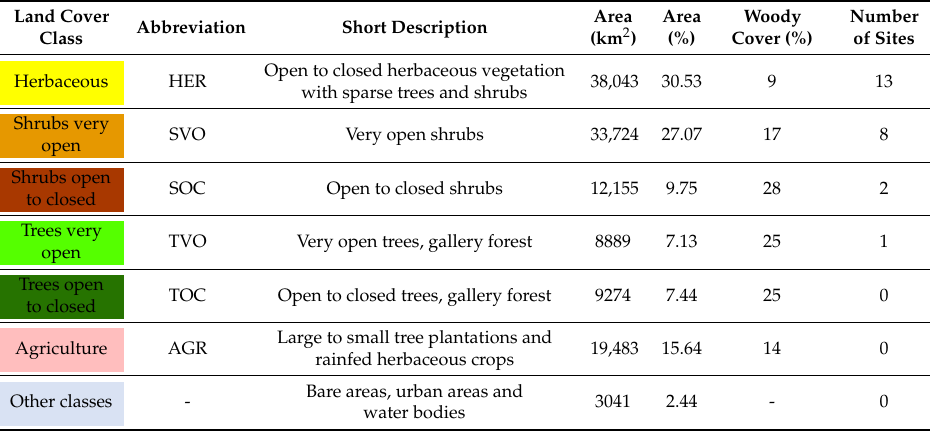
Figure 1. Location of the monitoring sites and the main land cover classes [51]. The sites are identified by their position in a grid where Cx indicates the column number and Ly corresponds to the line number with x and y varying between 1 and 9. The isohyets are based on average rainfall estimates provided by FEWS NET between 2000 and 2015 [44]. Table 1. General Descriptions of Land Cover Classes [53,54]. Woody Cover Values were obtained from the Woody Cover Map Provided by [15] and Correspond to the Averaged Values of Pixels Covered by Classes.